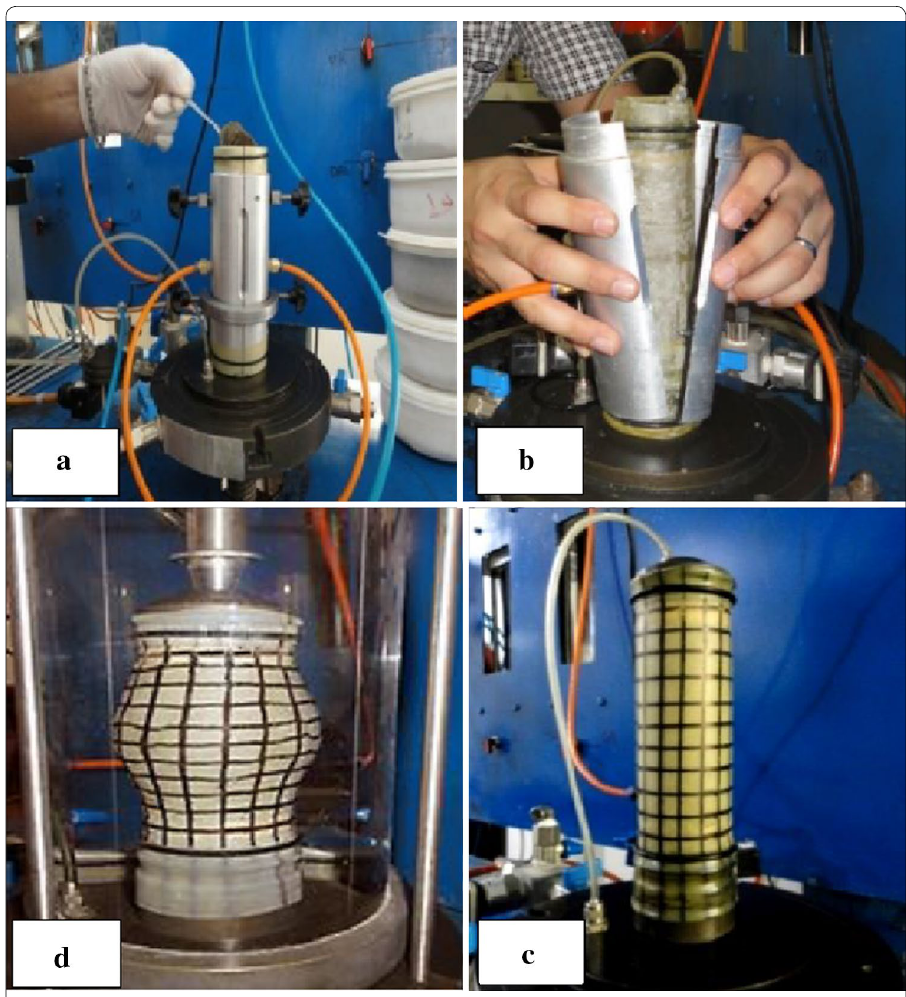
Fig. 6 The process of sample preparation ( a) pouring sand into mold, ( b) open the mold and applying suction to sample maintenance, ( c) prepare samples for testing and ( d) at the end of the test specimens